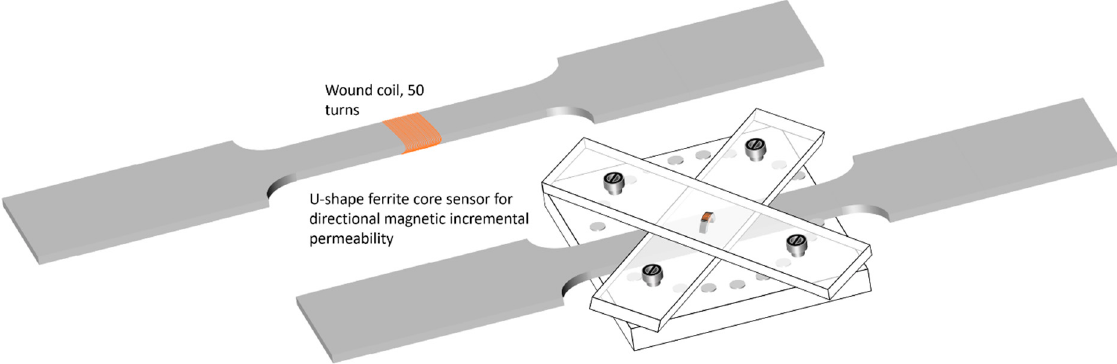
Figure 5. Illustration of the magnetic sensors used in this study.